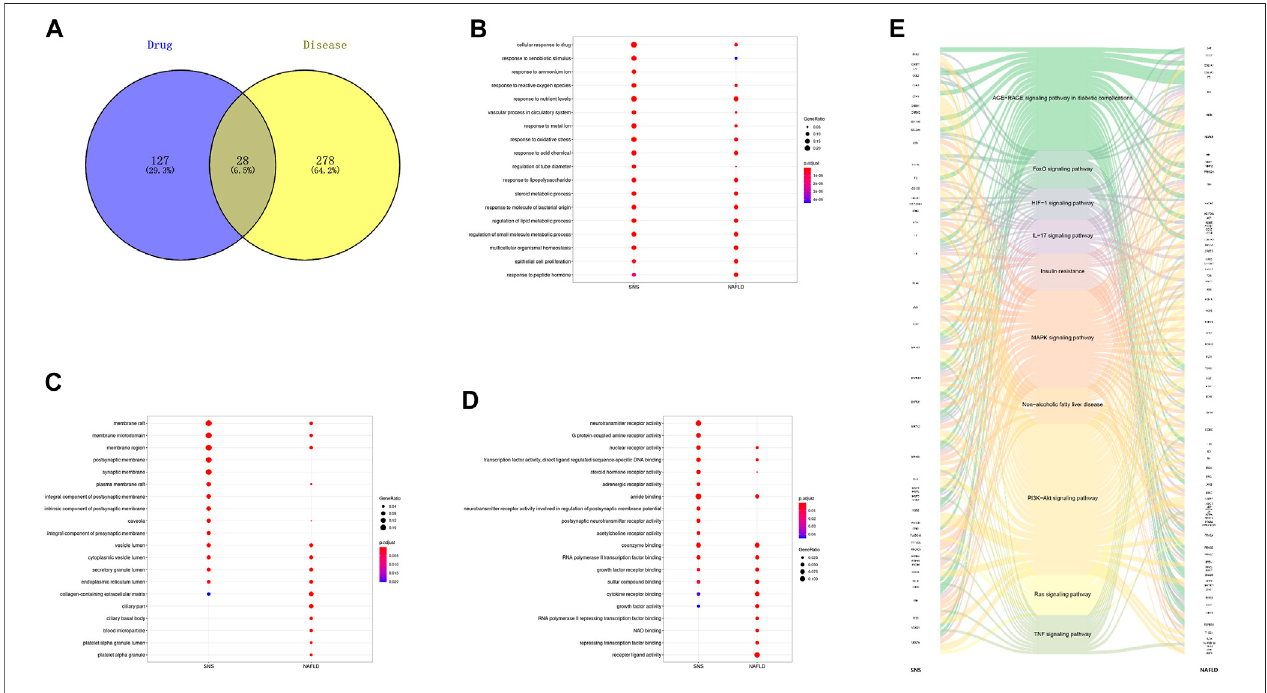
FIGURE 3 | Overlapped terms-based analysis. (A) Veen diagram of compound targets of SNS and NAFLD-related targets. Overlapped gene ontology (GO) and Kyoto Encyclopedia of Genes and Genomes (KEGG) terms of SNS and NAFLD: (B) biological processes (BPs), (C) cellular components (CCs), (D) molecular functions (MFs), and (E) KEGG